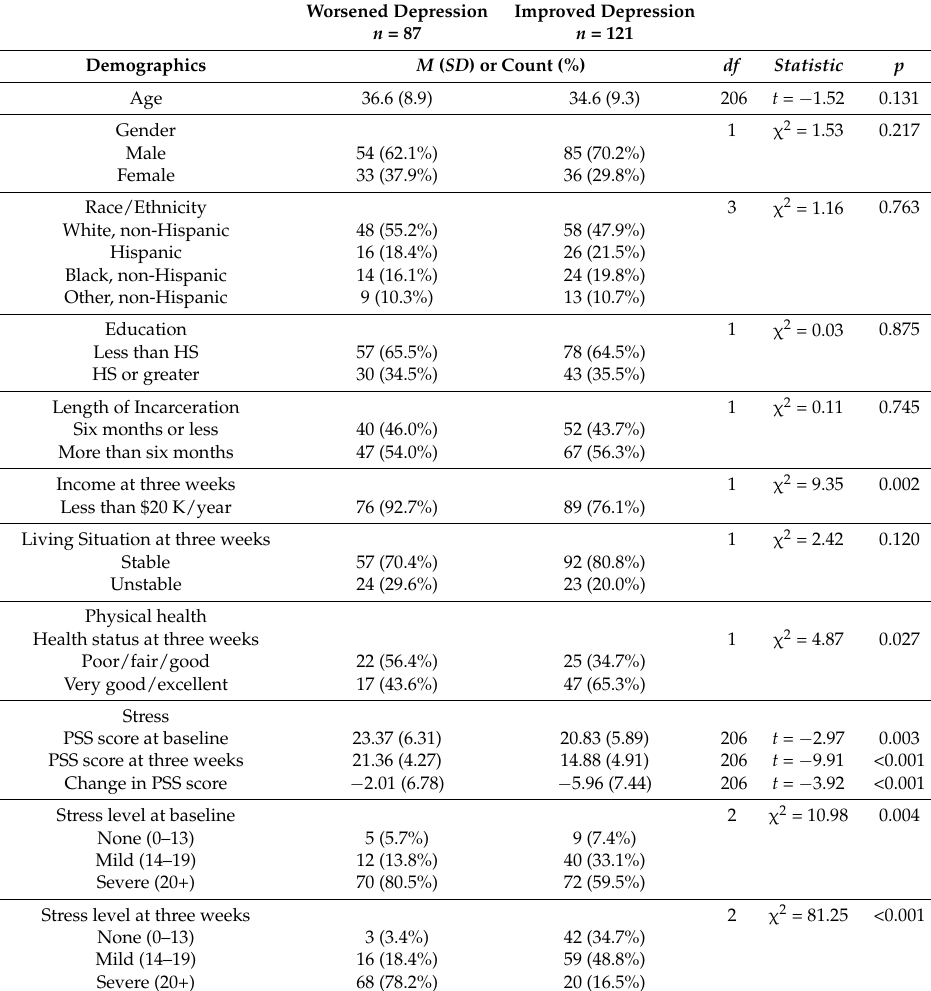
Table 1. Descriptive statistics and group difference analyses between those who worsened and those who improved in depression levels from baseline to